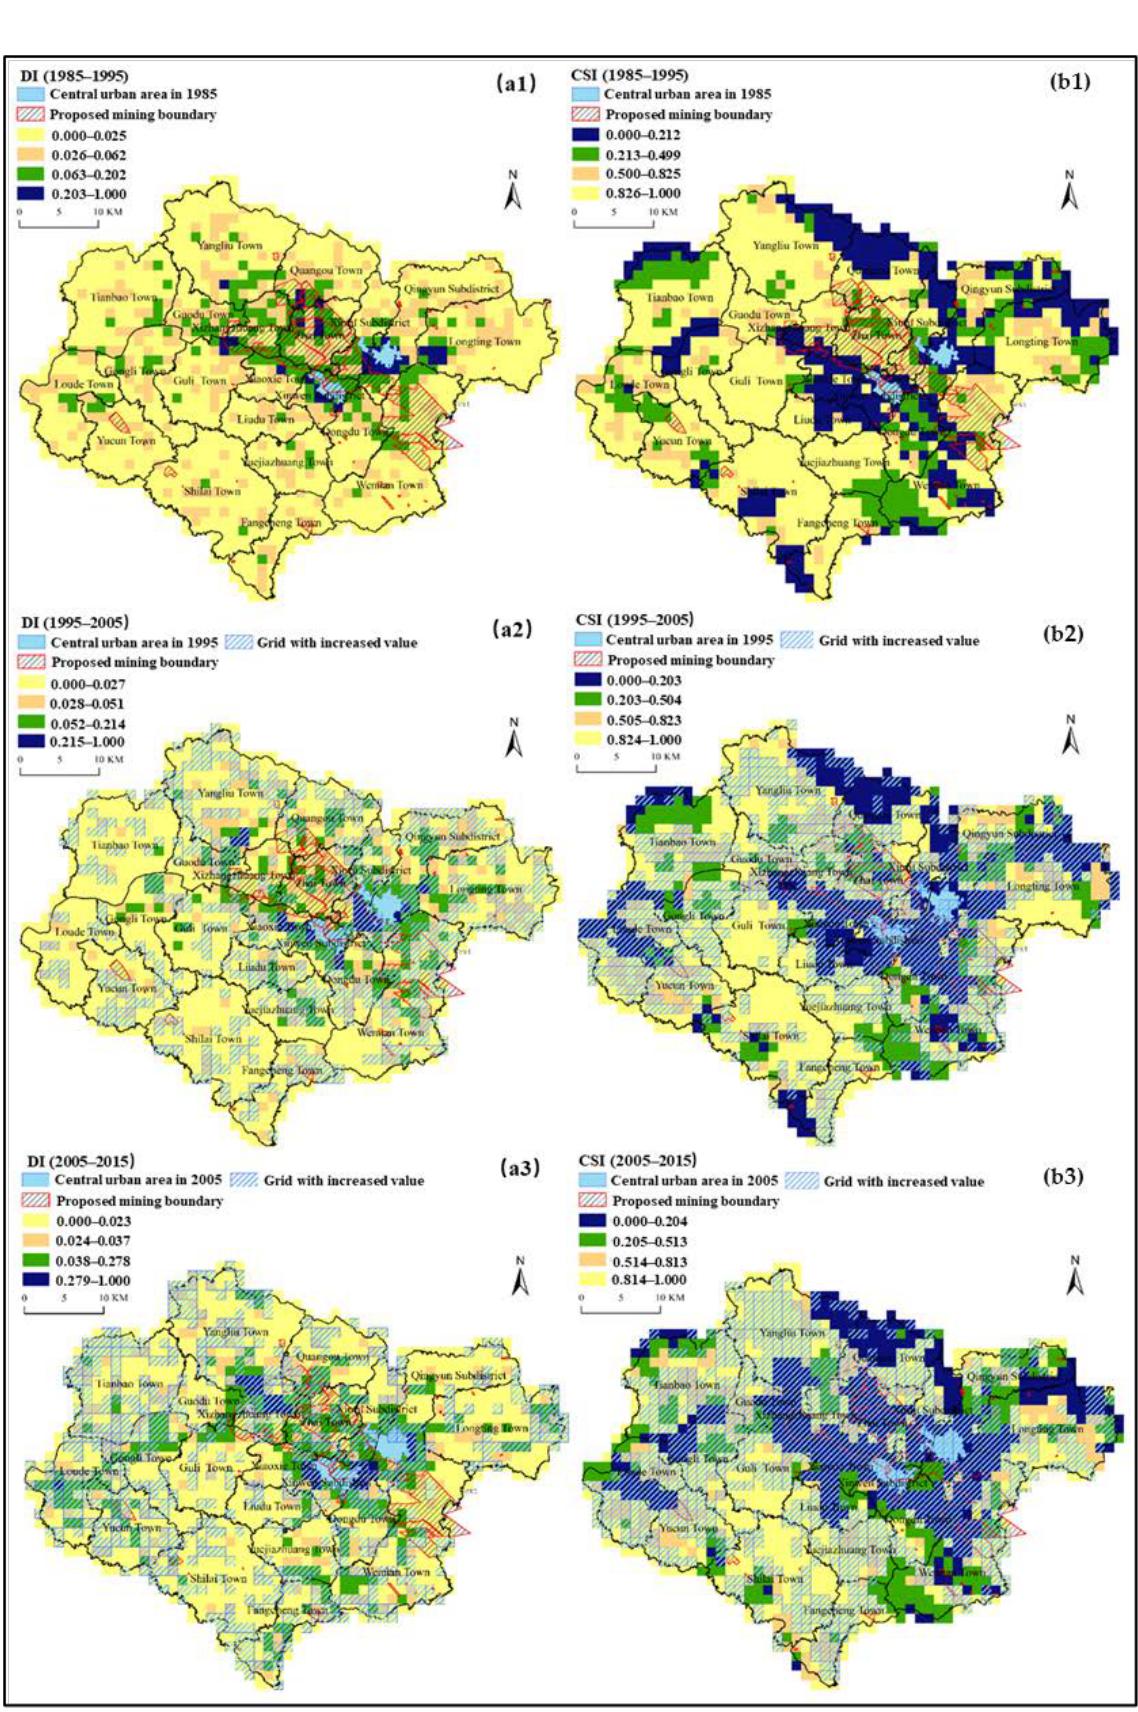
Figure 6. Temporal–spatial distribution of cultivated land DI and CSI. ( a1 ) disturbance index (DI) in 1985–1995. ( a2 ) disturbance index (DI) in 1995–2005, ( a3 ) disturbance index (DI) in 2005–2015. ( b1 ) cultivated surrounding index (CSI) in 1985–1995. ( b2 ) cultivated surrounding index (CSI) in 1995–2005. ( b3 ) cultivated surrounding index (CSI) in